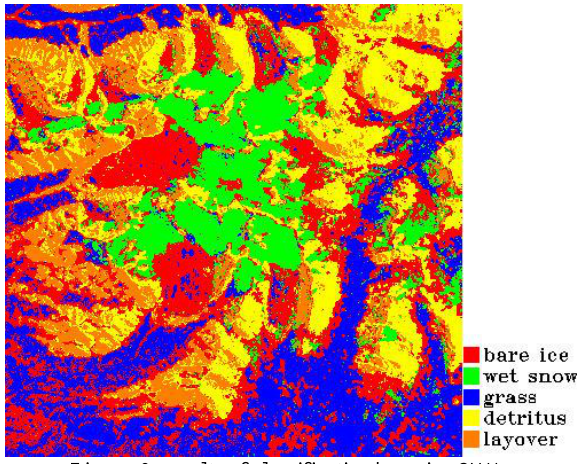
Figure 9. results of classification by using